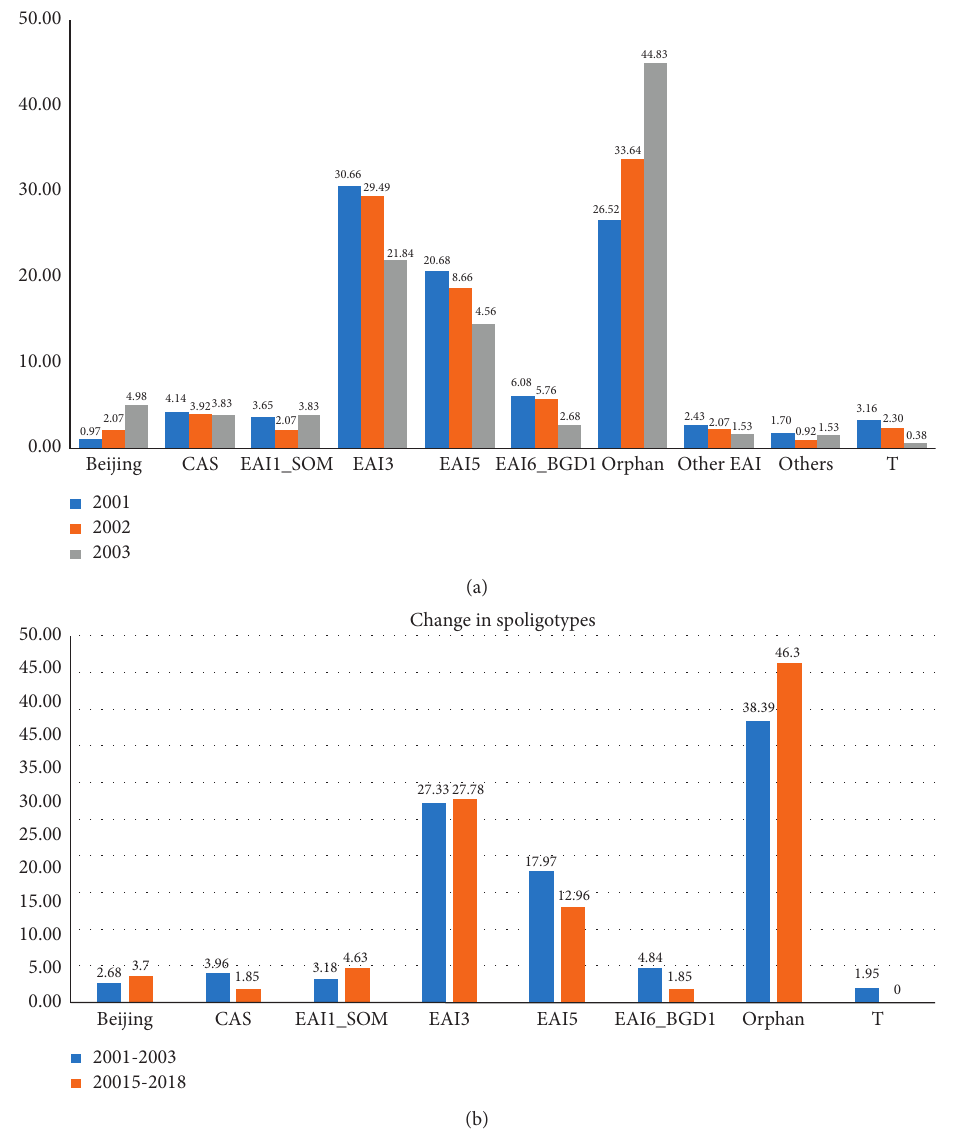
Figure 1: (a) Distribution of spoligotype from the year 2001 to 2003; there is a marked increase in orphan and a decrease in EAI5 and EAI3 strains. (b) Comparison of spoligotype distribution between the years 2001–2003 and 2015–2018; this shows a marked increase in orphan and a decrease in EAI5 strains in this